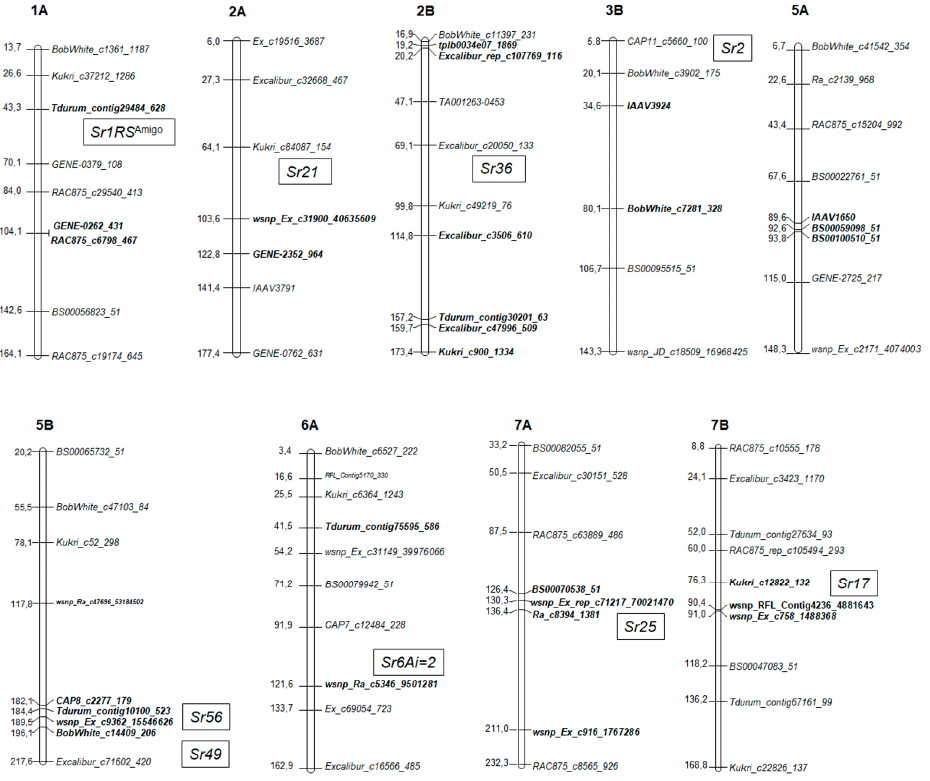
Figure 4. Schematic illustration of the localization of loci determining resistance to stem rust in wheat genotypes. Markers identified in this paper are indicated in bold. The order of the markers corresponds to the consensus chromosome maps for the SNP [23]. Known Sr resistance genes were added at the right side of the chromosomes according to published data [19].